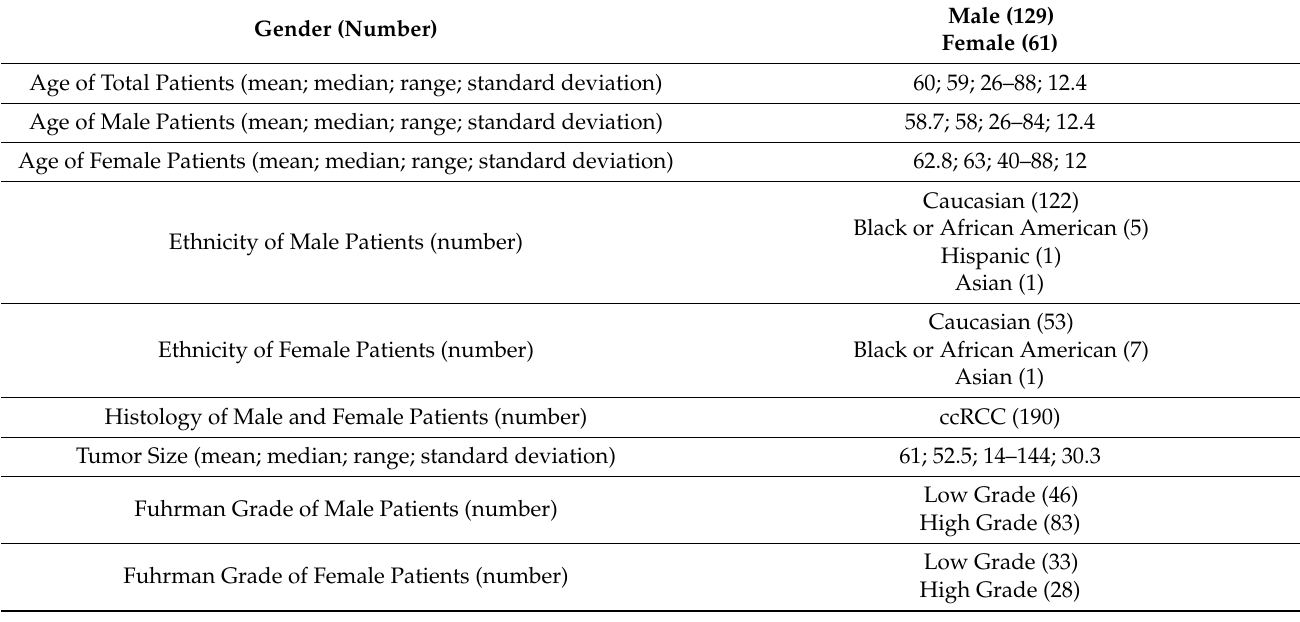
Table 1. Descriptive data of the enrolled